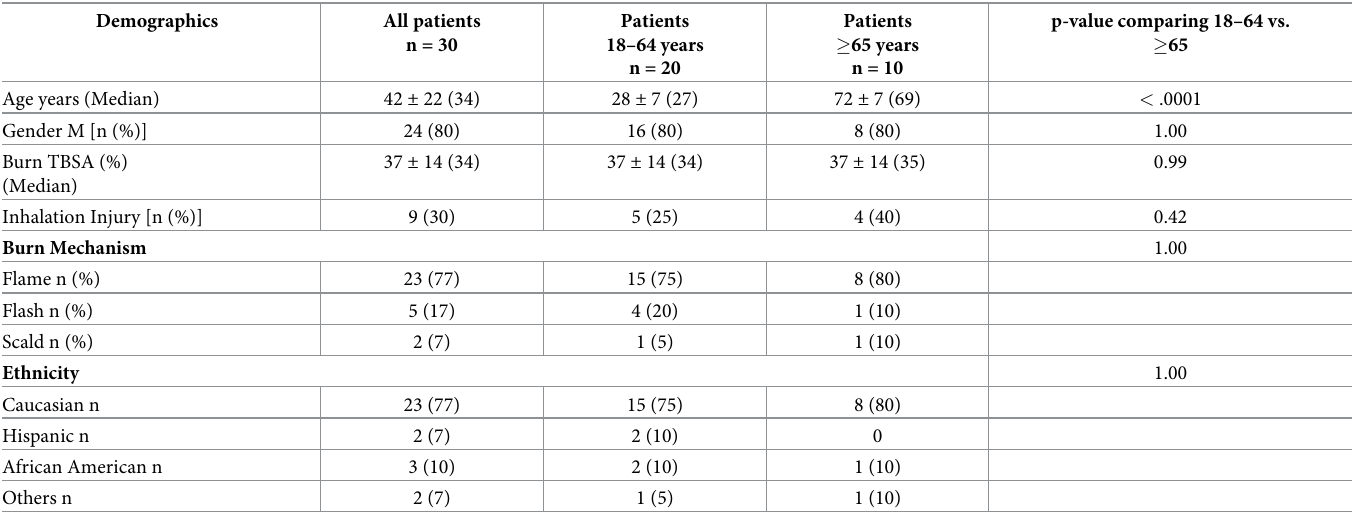
Table 1. Demographics.